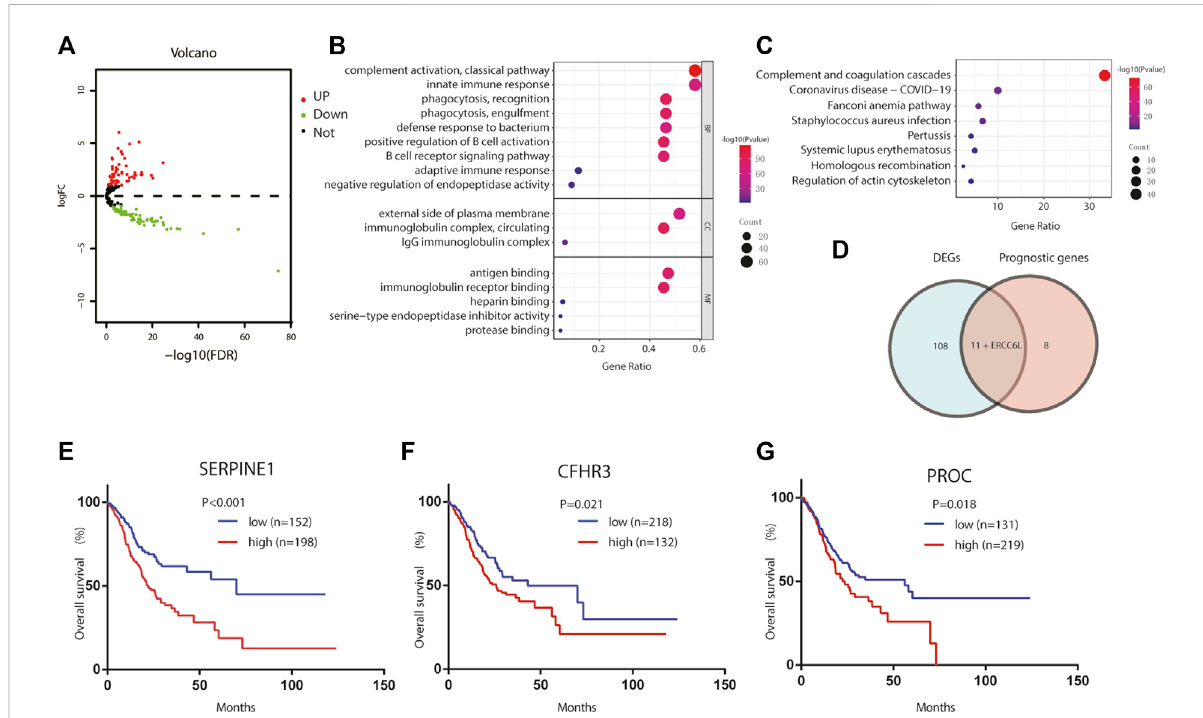
FIGURE 2 Identi fi cation of the candidate complement system-related genes in TCGA cohort. (A) Volcano plots visualize the complement system-related DEGs in TCGA STAD. (B) GO analysis of complement system-related DEGs. (C) KEGG analysis of complement system-related DEGs. (D) Venn diagram to identify DEGs between tumor and adjacent normal tissue that were correlated with OS. (E – G) Prognostic values of (E) SERPINE1, (F) CFHR3, and (G) PROC in TCGA STAD. GO, Gene Ontology; KEGG, Kyoto Encyclopedia of Genes and Genomes; DEGs, differentially expressed genes; OS, overall survival.